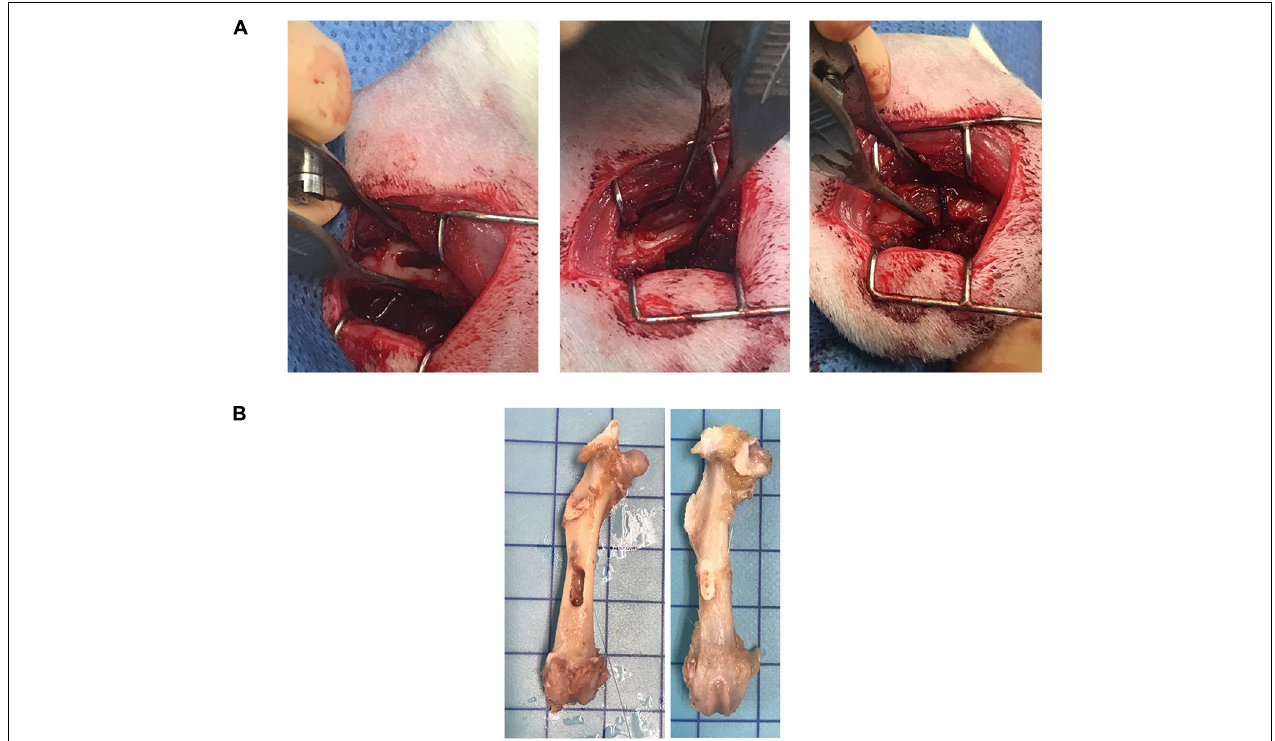
FIGURE 7 | Surgical procedure. (A) A total of 6 mm × 2 mm window defect was created by connecting three circular defects using 1.9 drill bur. Scaffold was implanted inside the defect and suture was applied to stabilize the scaffold. (B) Representative image of pre-implanted and 6 weeks post-implanted femur with the marker representing 10 mm × 10 mm square.